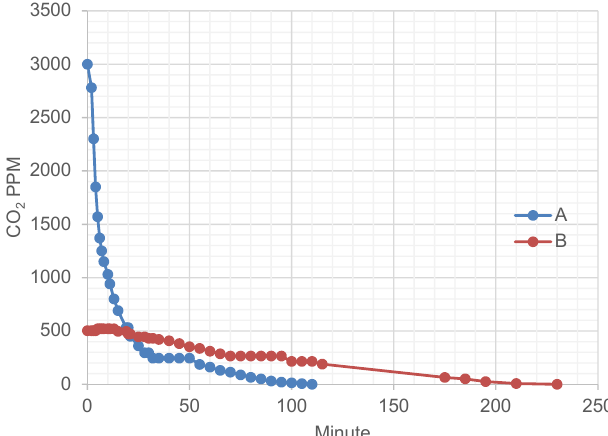
Fig. 2: Decreasing CO 2 concentrations in time by the reaction with NH 3